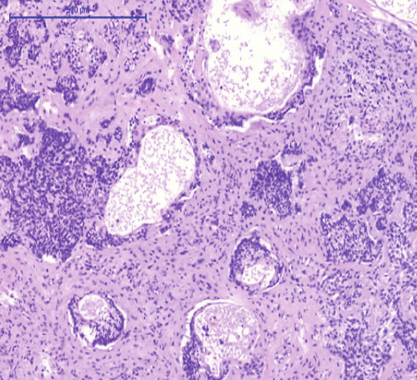
Figure 3: HE-staining. Hepatic bile ducts with transition from metaplastic to dysplastic epithelium and invasion.